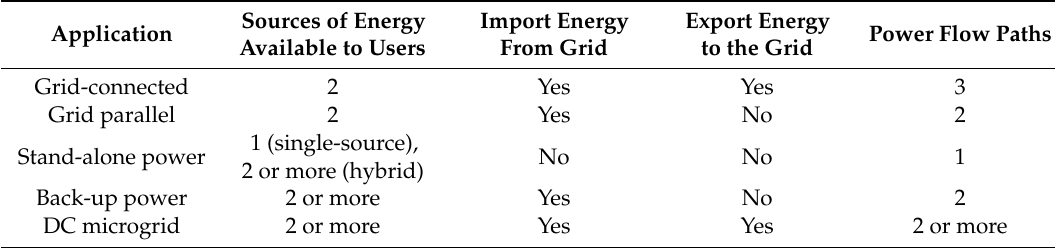
Table 4. Comparison of the FC microgrid applications